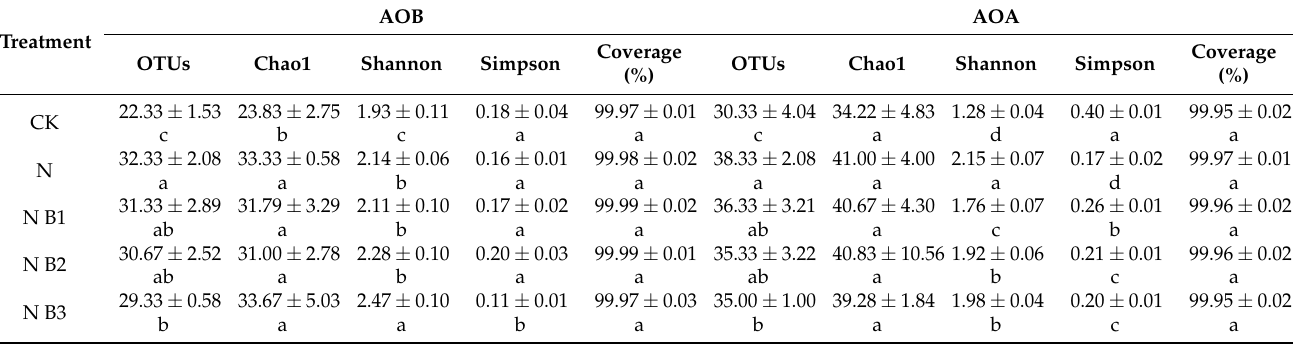
Table 3. Richness and diversity indexes of AOB and AOA, plus the statistical comparison of com- munity indexes among all treatments using the one-way ANOVA with the least significant differ- ence